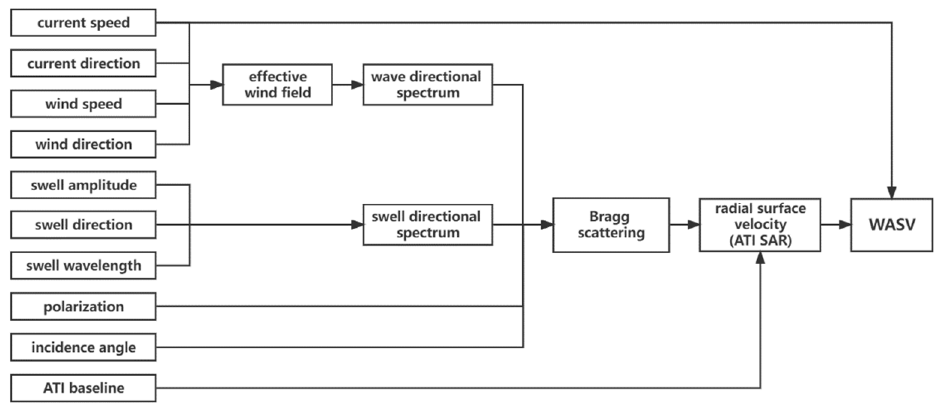
Figure 4. Flow chart of numerical simulation of WASV.